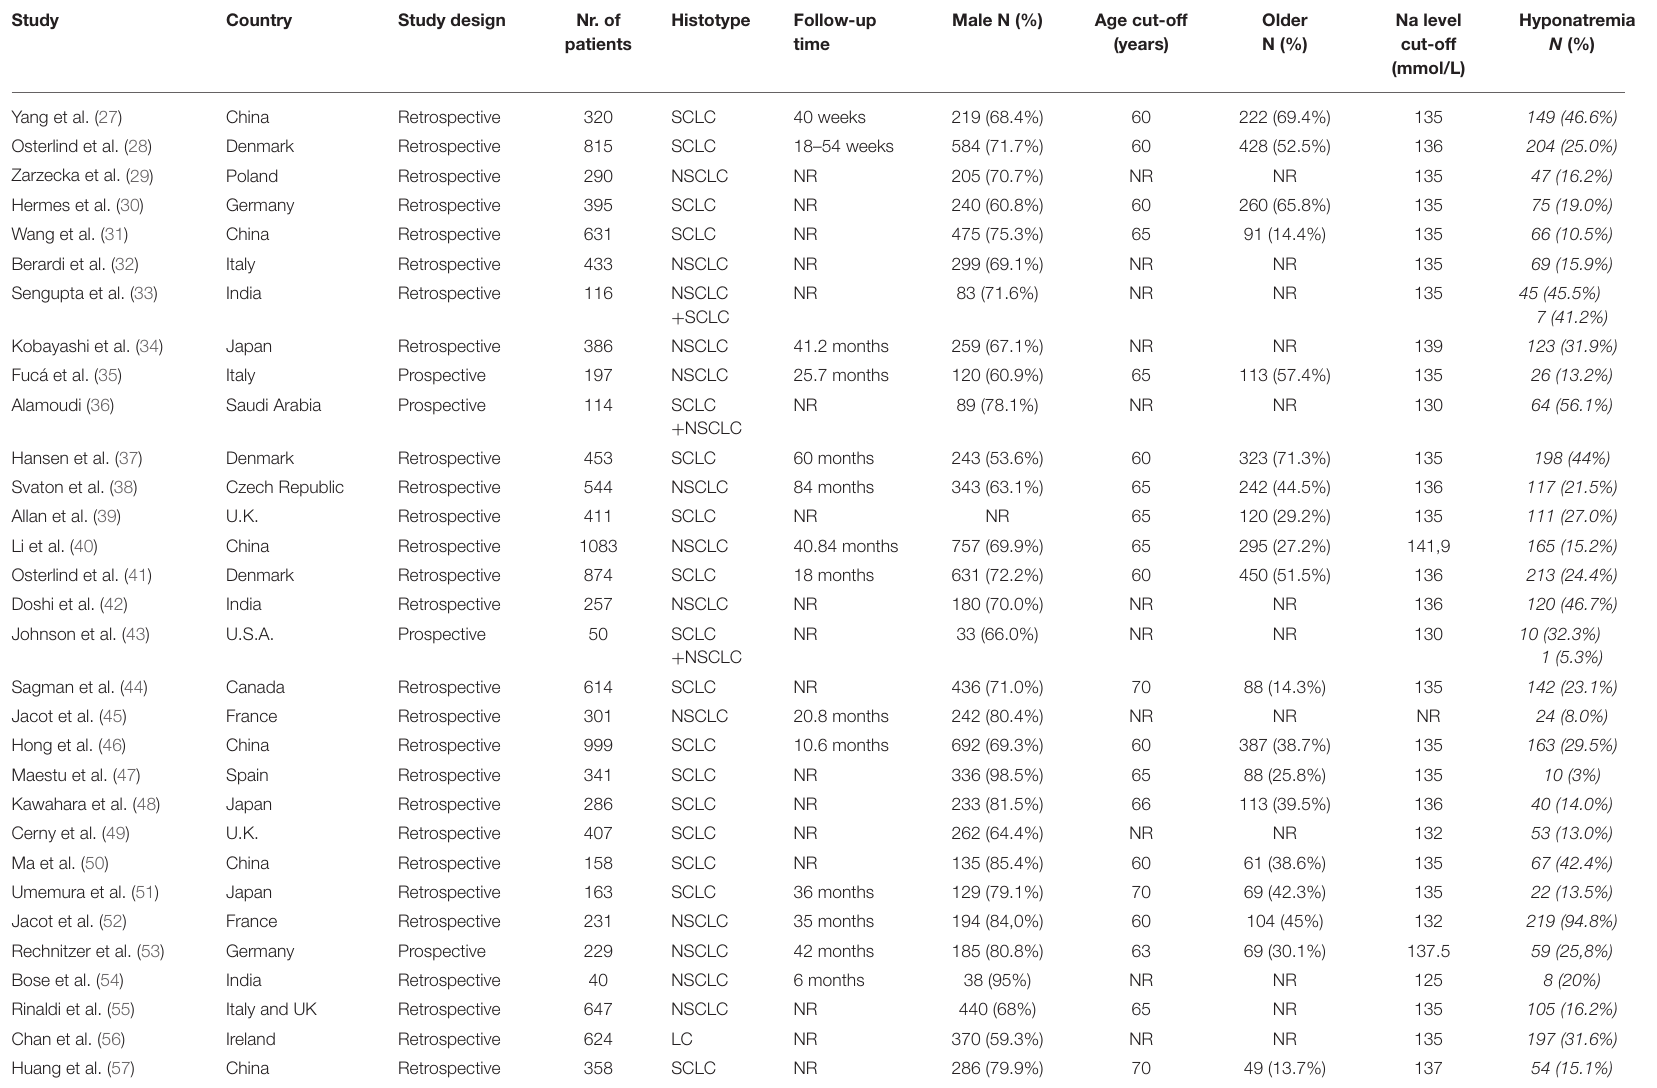
TABLE 1 | Characteristics of the included studies in the systematic